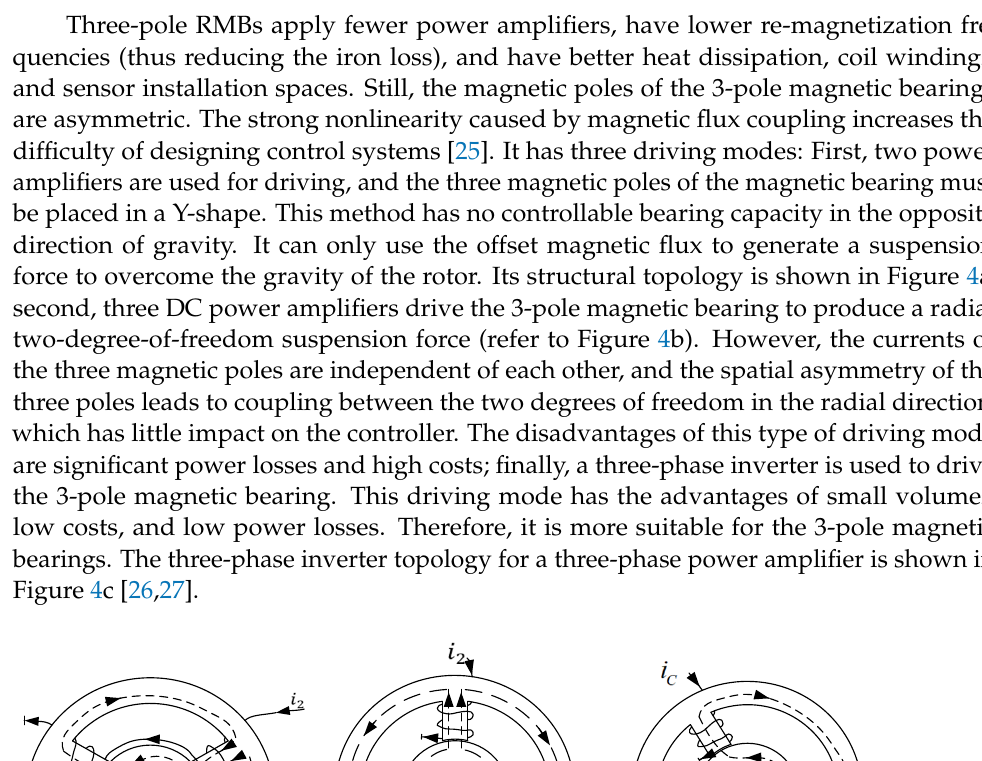
(c) Figure 5. The 6 ‐ pole RMB structure. ( a ) Hybrid permanent magnet structure. ( b ) Six ‐ power ampli ‐ fier drive models. ( c ) Three ‐ phase six ‐ pole drive models. The working model for a three ‐ phase 6 ‐ pole RMB is that if the rotor deviates in the A2 direction, a positive control current must be applied to coils A1 and A2 to return the